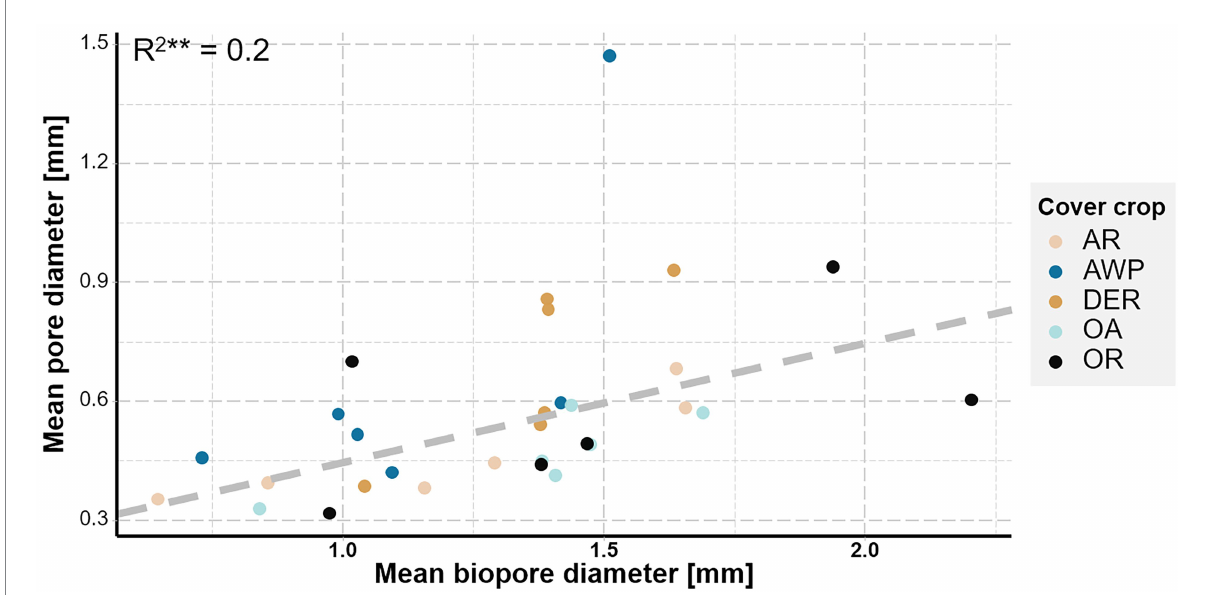
FIGURE 5 Mean pore diameter plotted versus mean biopore diameter. Colors represent the studied cover crop species. Dashed line represents the linear regression fitted to the